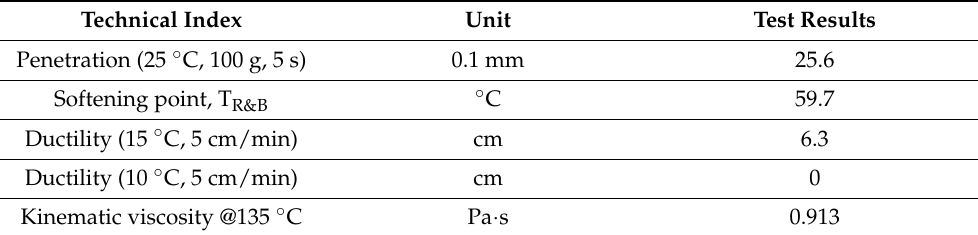
Table 2. Technical indices of PAV-aged asphalt binder.